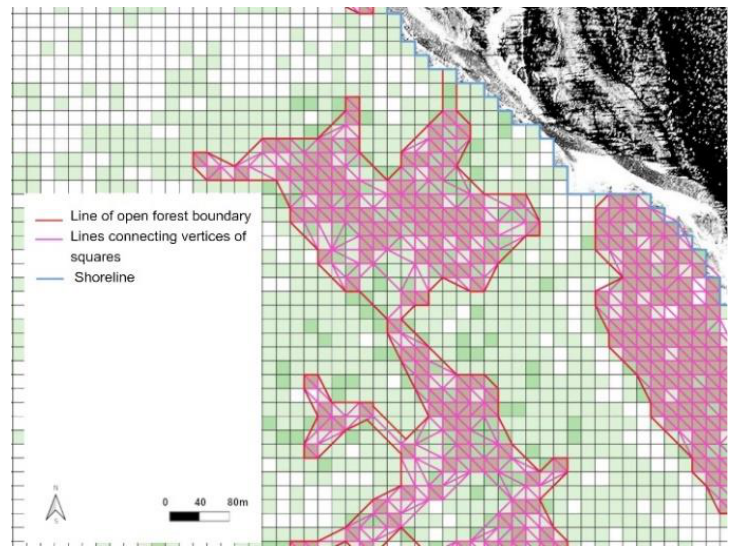
Figure 5. The vertices of squares with crown closures of 0.1 or more connected with lines no longer than 60 m.